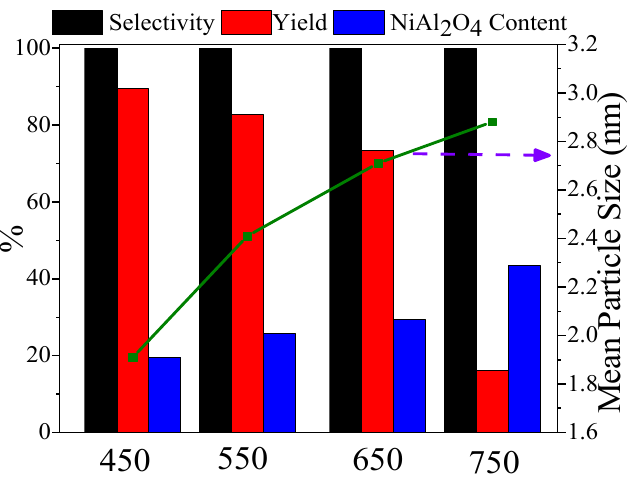
Figure 11. Effect of calcination temperature on the catalytic activity of Ni 10 Mo 10 Al catalyst under the reaction conditions of 100 °C, 1 MPa H 2 , n(H 2 )/n(MA) = 4 and WHSV = 2 h − 1 .